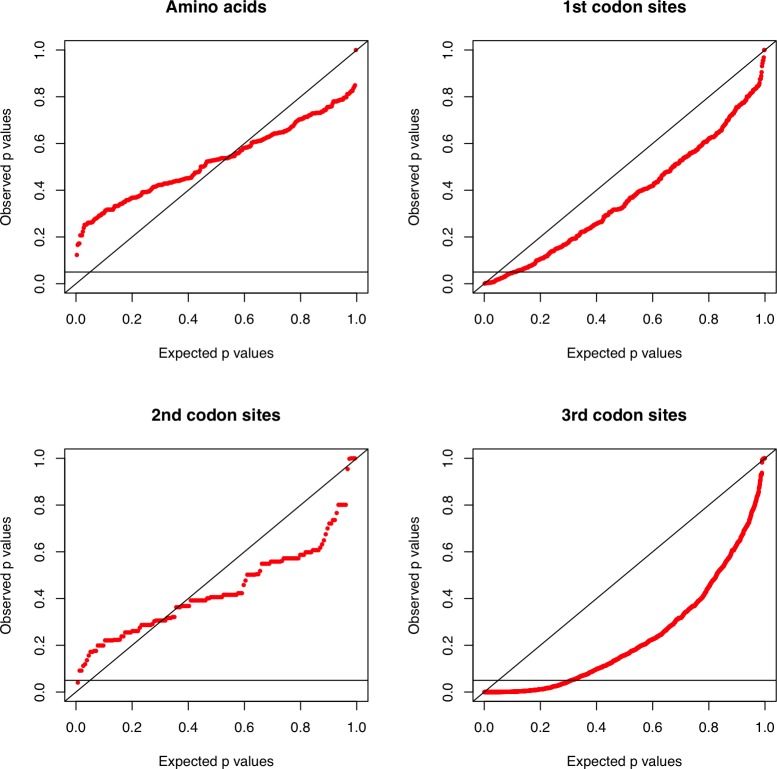
PP-plots for P values distributions from matched-pairs tests of symmetry for mtDNA COI sequence data sets.PP-plots with the distributions of P values from the matched-pairs tests of symmetry for the following data sets: amino acids, first codon sites, second codon sites, and third codon sites. A J-shaped distribution of dots, with more than 5% of the dots below 0.05 (i.e., the horizontal line) indicates violation of the assumption of evolution under globally SRH conditions. The PP-plot for third codon sites represents a clear example of violation of this phylogenetic assumption.